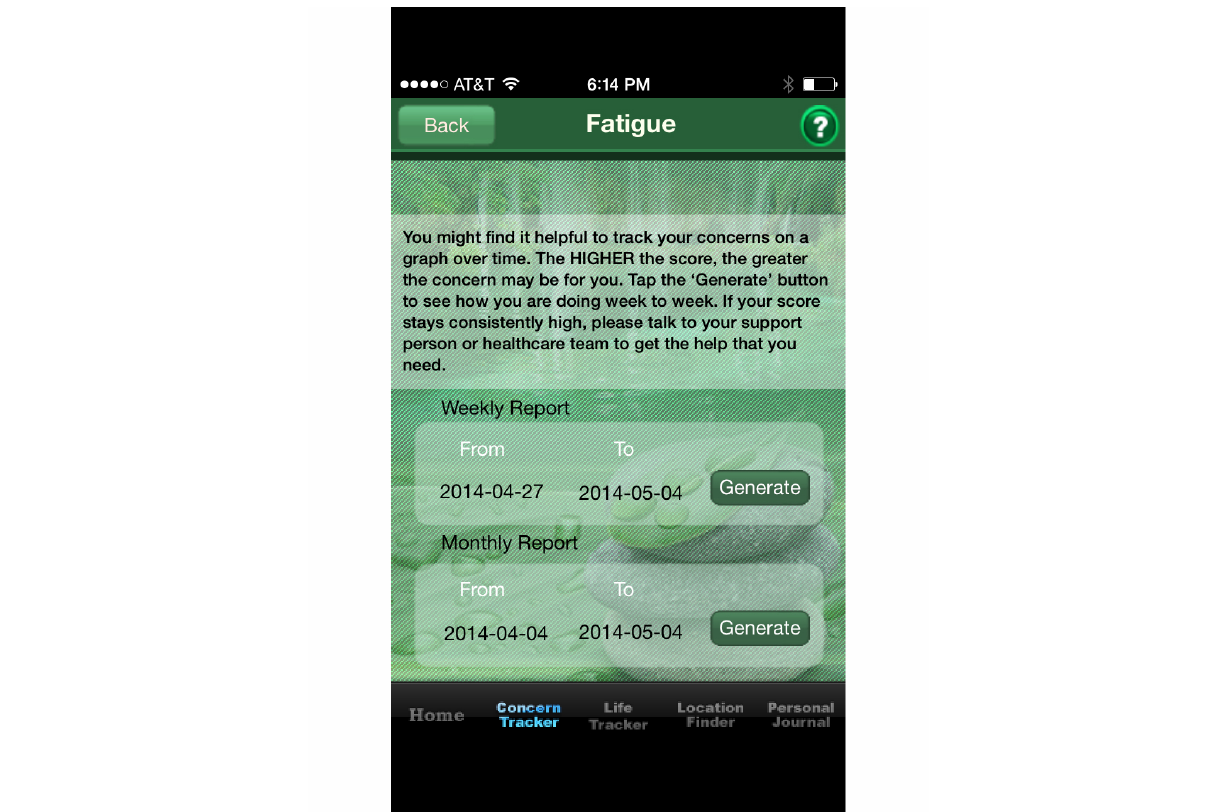
Figure 5. My Cancer Manager